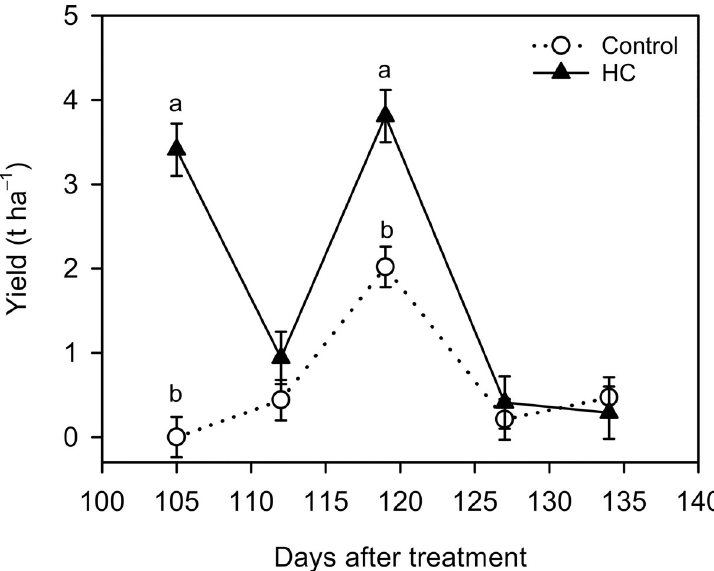
Fig 5. Weekly yield of ‘Emerald’ blueberry grown under inadequate chilling conditions as affected by hydrogen cyanamide (HC) in the 2019–2020 season (Expt. 2). Treatments included water control and 1.0% HC (9.35 L ha –1 or 1.74 mL/plant) sprayed at 935 L ha –1 on 17 December 2019. A non-ionic surfactant (Agri-Dex) was added at 0.5% (v/v) to both water control and HC treatments. Means (n = 3–4) with the same or no letter within each measurement day are not significantly different (Tukey–Kramer test, P <